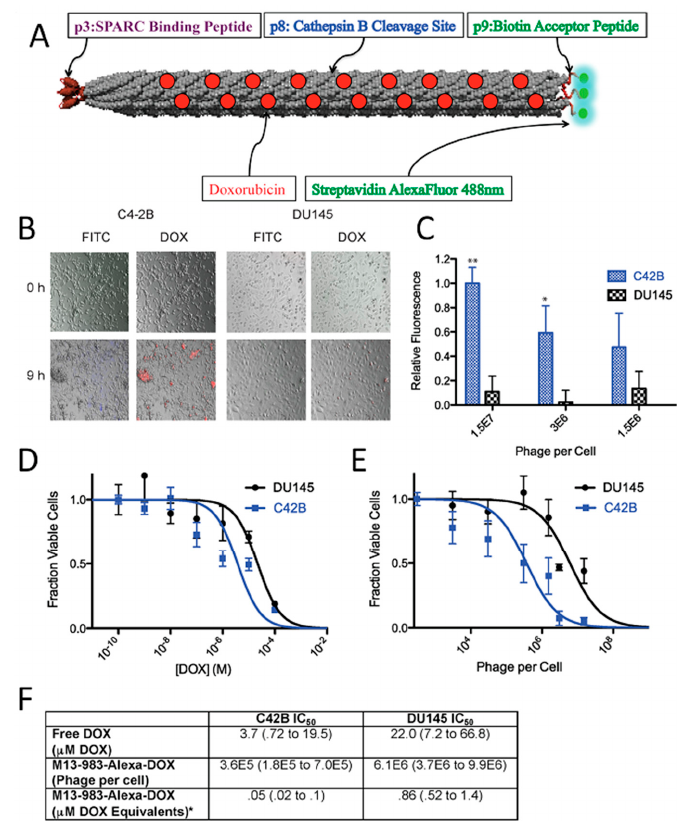
Figure 3. ( A ) Schematic of M13-983 Phage. The red dots along the phage coat represent doxorubicin (DOX) attached to p8. p3 displays a peptide with affinity for SPARC (Secreted Protein, Acidic and Rich in Cysteine), and p9 can be enzymatically biotinylated and loaded with streptavidin-functionalized fluorophores AlexaFluor 488 nm. ( B ) Overlay of brightfield and fluorescent images of SPARC positive C42B cells (first and second column) and less expressing SPARC DU145 cells (third and fourth column) incubated with M13-983-Alexa-DOX at 0 h (top row) and 9 h post-treatment (bottom row). FITC channel represents fluorescence from Alexa Fluor 488, and DOX is designated by red fluorescence from DOX uptake. C42B samples showed increased fluorescence of phage uptake, indicated by green fluorescence (bottom row, first column) and DOX uptake (bottom row, second column) as compared to DU145 cells after 9 h. ( C ) Targeted uptake measured by quantifying fluorescence intensity (** p < 0.001; * p < 0.01). C42B consistently shows higher fluorescence intensity than DU145, confirming the observations in panel B. Higher phage concentrations report larger di ff erences between C42B and DU145 fluorescence. ( D ) Cell viability of C42B and DU145 as a function of free DOX. ( E ) Cell viability of C42B and DU145 cell lines as a function of increasing M13-983-Alexa-DOX. All samples were run in triplicate and error bars represent standard deviations. ( F ) IC50 values for C42B and DU145 are given with the 95% confidence interval given in parenthesis. * Based on 257 DOX particles per phage (Adapted with permission from [84], Copyright American Chemical Society,